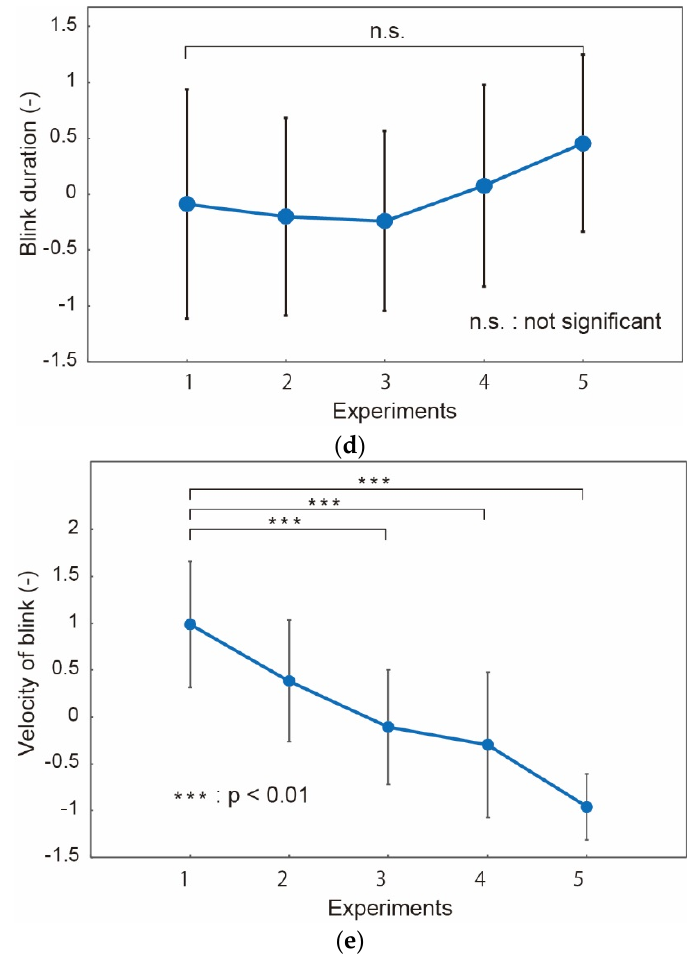
Figure 8. Obtained ( a ) the number of blinks, ( b ) the number of blink bursts, ( c ) the blink burst rate, ( d ) the blink duration, and ( e ) blink velocity with respect to the number of U–K tests. “ p ” represents the p -value in statistics hypothesis testing.